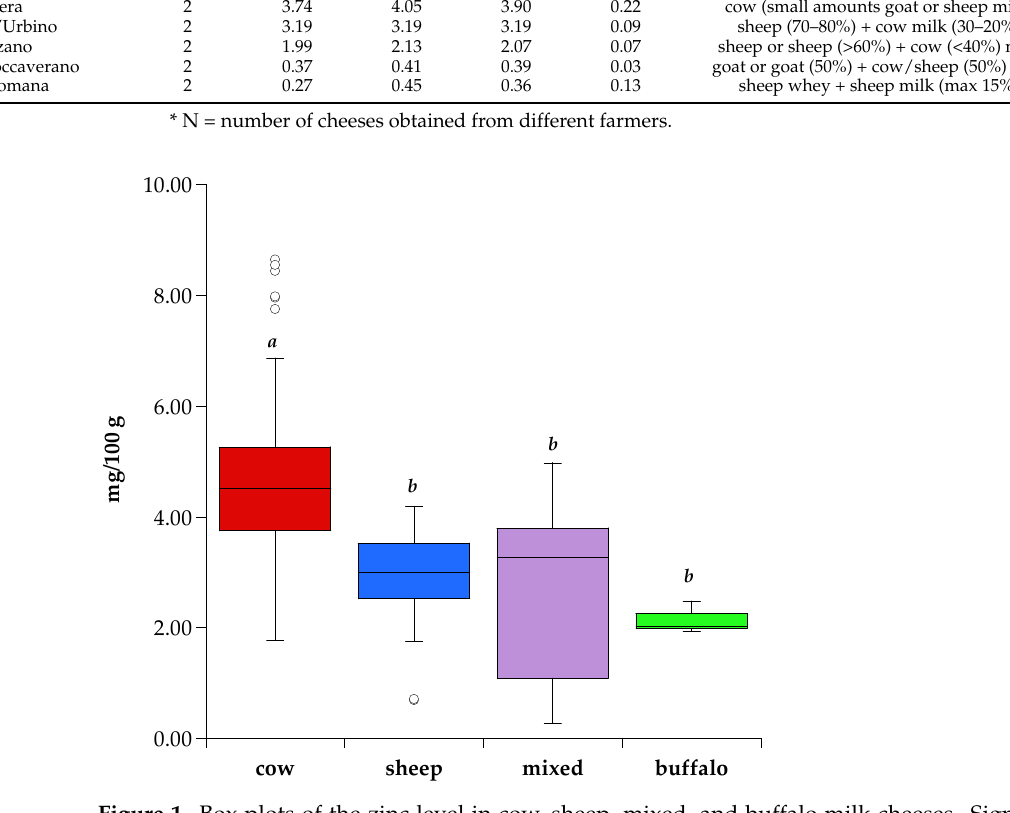
Figure 1. Box plots of the zinc level in cow, sheep, mixed, and buffalo milk cheeses. Significant differences ( p < 0.05) are identified with different letters ( a , b ).